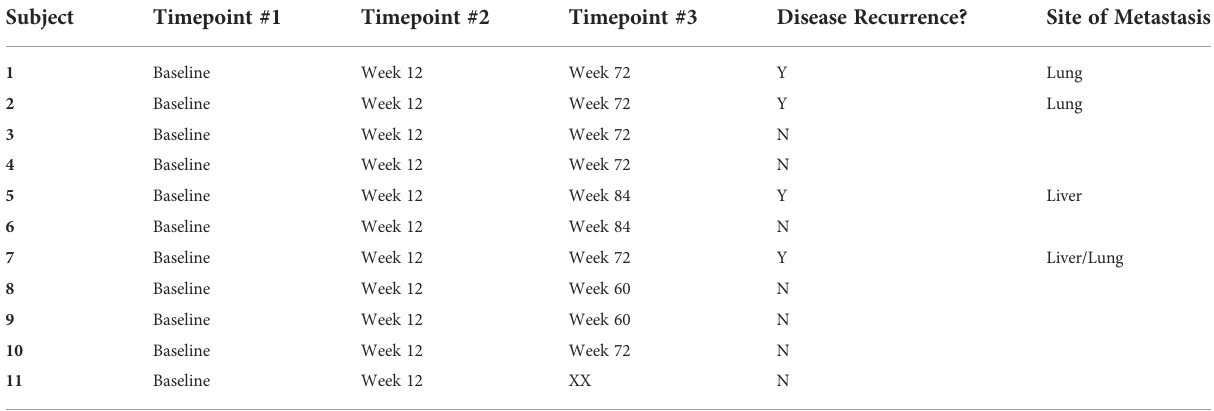
TABLE 6 Samples analyzed for extracellular vesicle protein content.